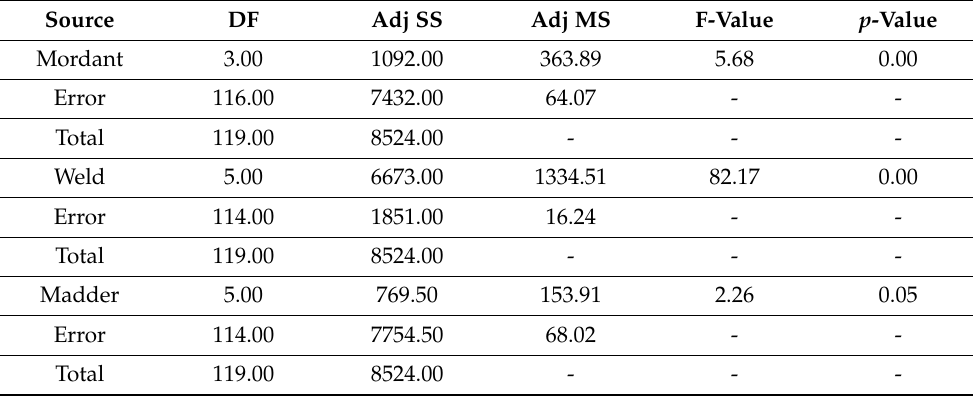
Table 2. Results of ANOVA for a* color coordinate.